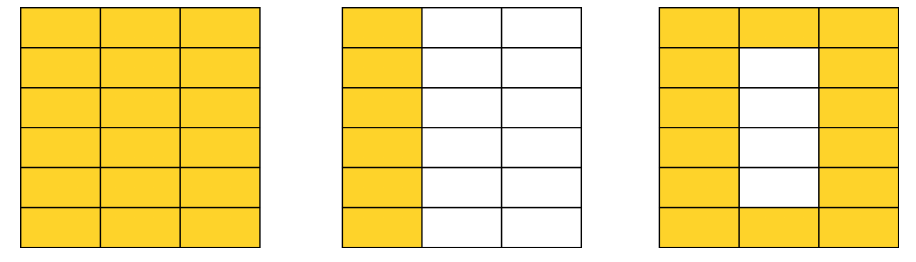
Figure 7: First iteration of Bedford-McMullen carpets with generators A . On the left, A = A 0 (the square). In the middle, A = A 1 (a vertical line). On the right, A = { (1, 1), . . . , (1, 6), (2, 1), (2, 6), (3, 1), . . . , (3, 6) }